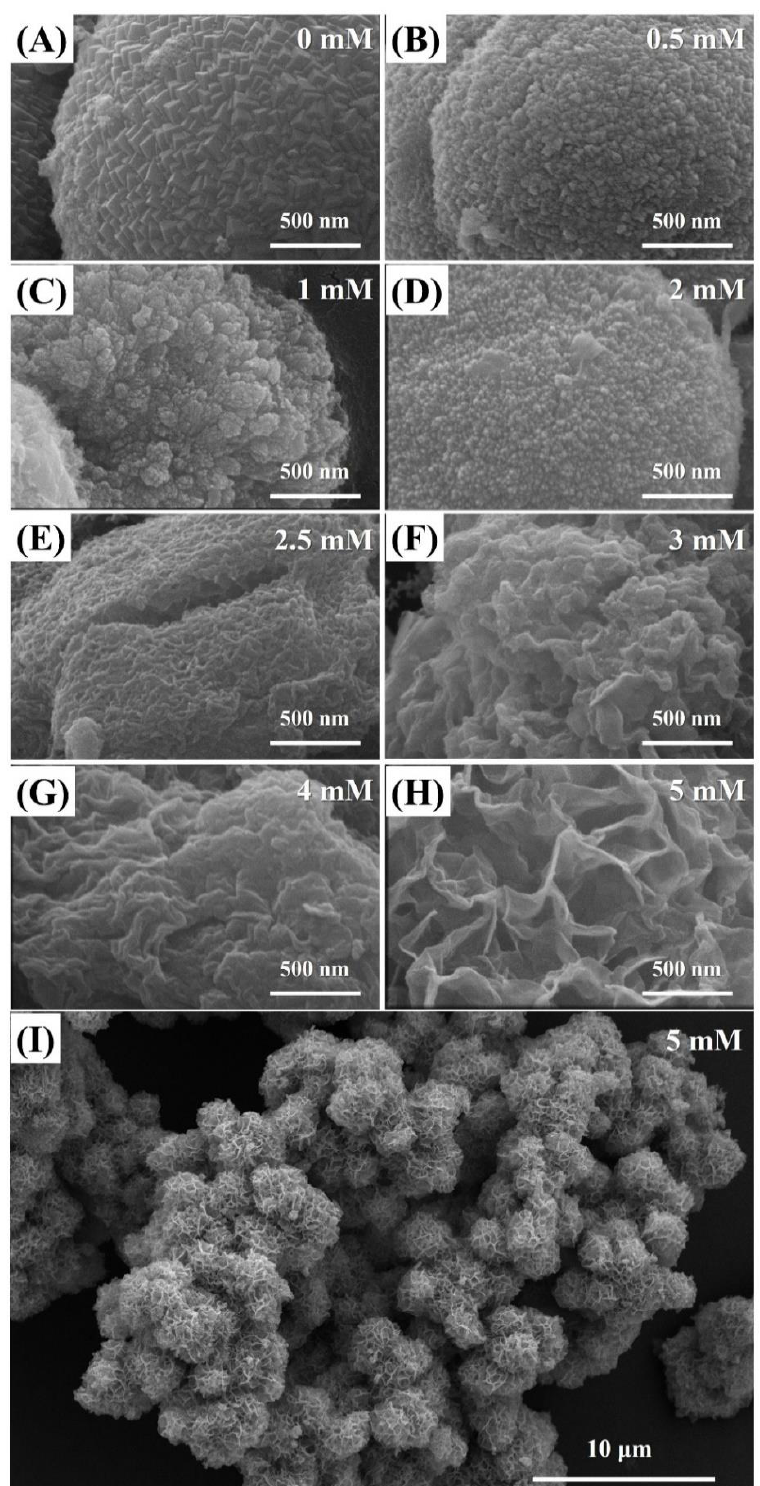
Figure 2. ( A – H ) Scanning electron microscopy (SEM) images for the CF-NCs synthesized in the presence of different citrate concentrations (0–5 mM); ( I ) is the low-magnification image of ( H ).